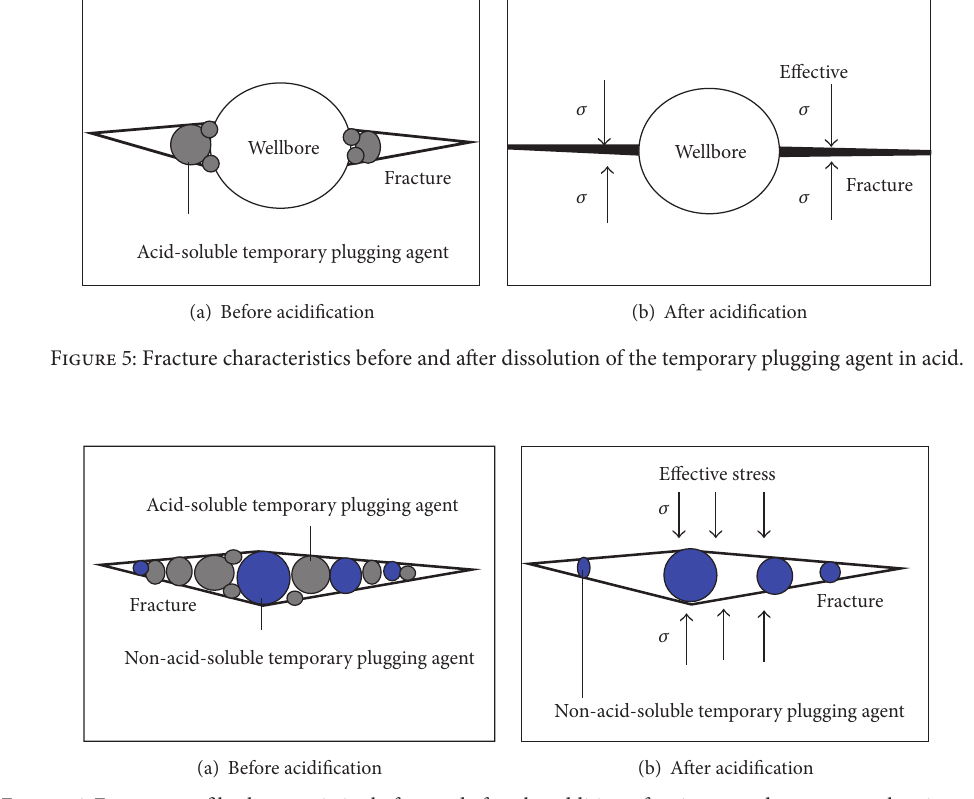
Figure 6: Fracture profile characteristics before and after the addition of an integrated temporary plugging agent.